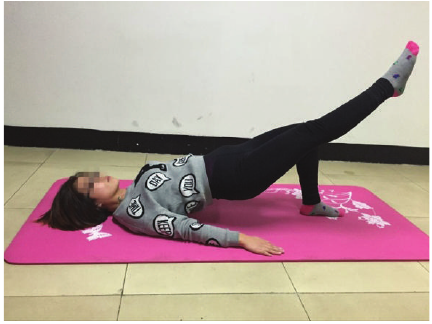
Figure 2: Supine bridge.